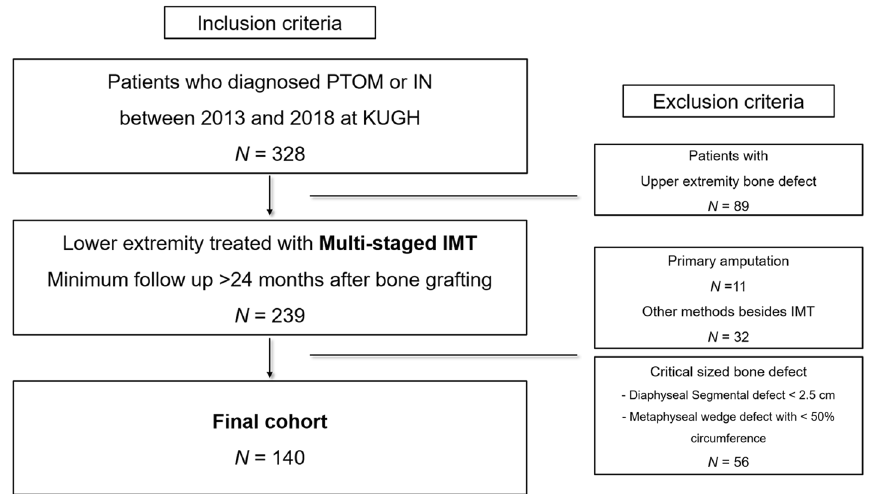
Figure 1. Final cohort based on inclusion and exclusion